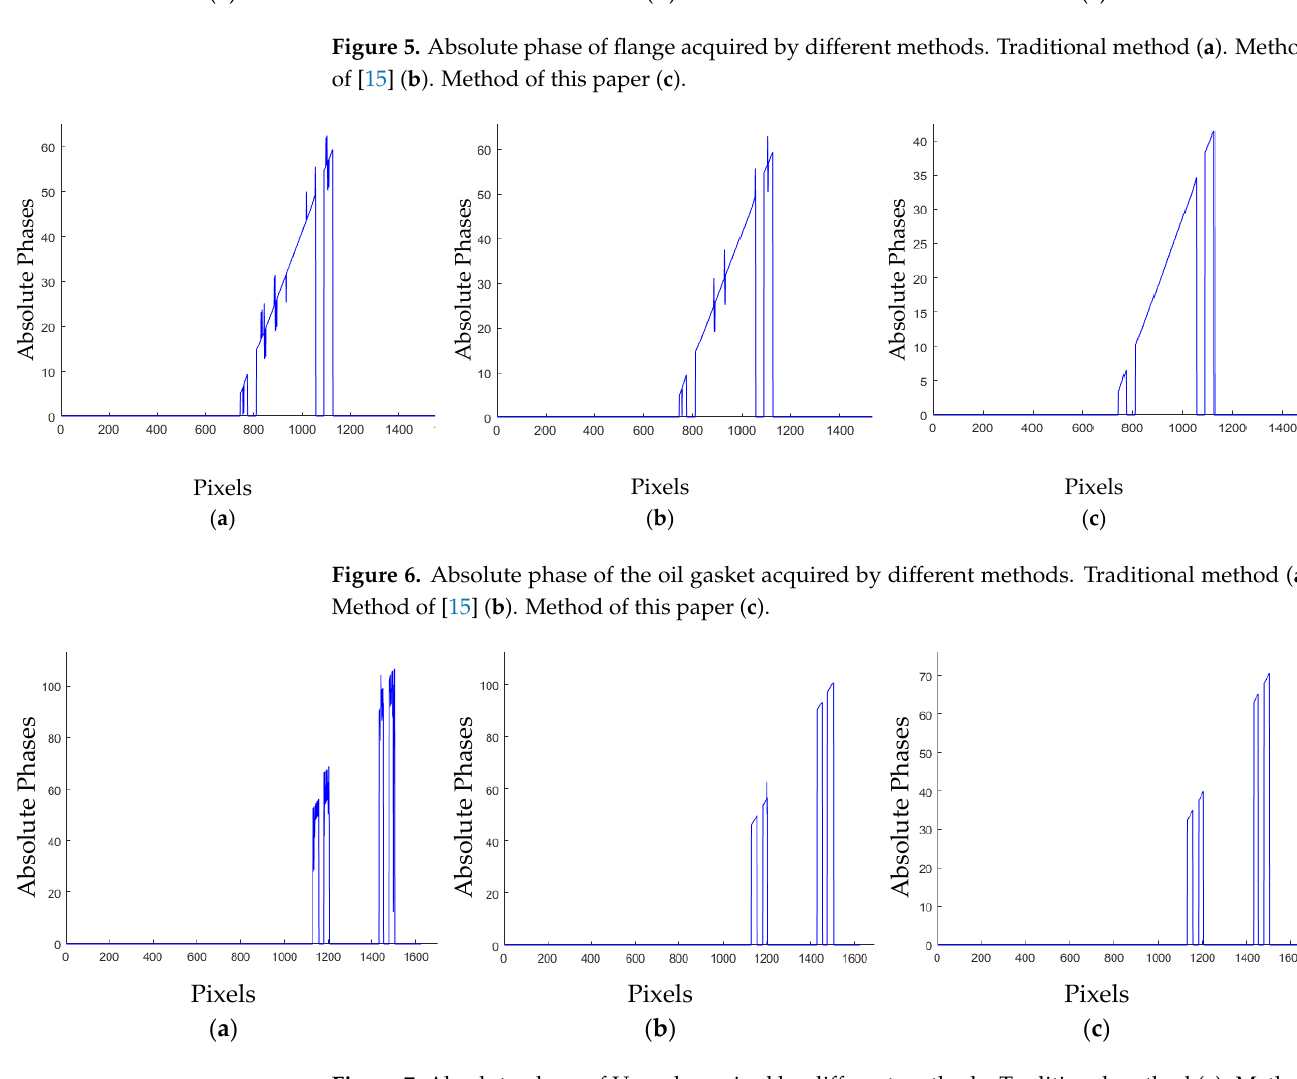
( c ) Figure 8. The 3D point cloud image measured by the method in this paper. The 3D point cloud of fl ange ( a ). The 3D point cloud of oil gasket ( b ). The 3D point cloud of U-card ( c ). In this paper, the internal and external parameters of the camera are obtained by us- ing Zhang Zhengyou’s camera calibration technique [22]. Then the grating fringe is pro- jected to the measured object, and the phase principal value of the measured object is ob- tained. The technique in this paper is used to expand the phase principal value, and fi nally the reconstructed 3D point cloud image of the measured object is obtained combined with the calibration parameters. In order to prove the applicability and universality of the tech- nique, three mechanical workpieces including fl ange, oil gasket, and U-shaped card were